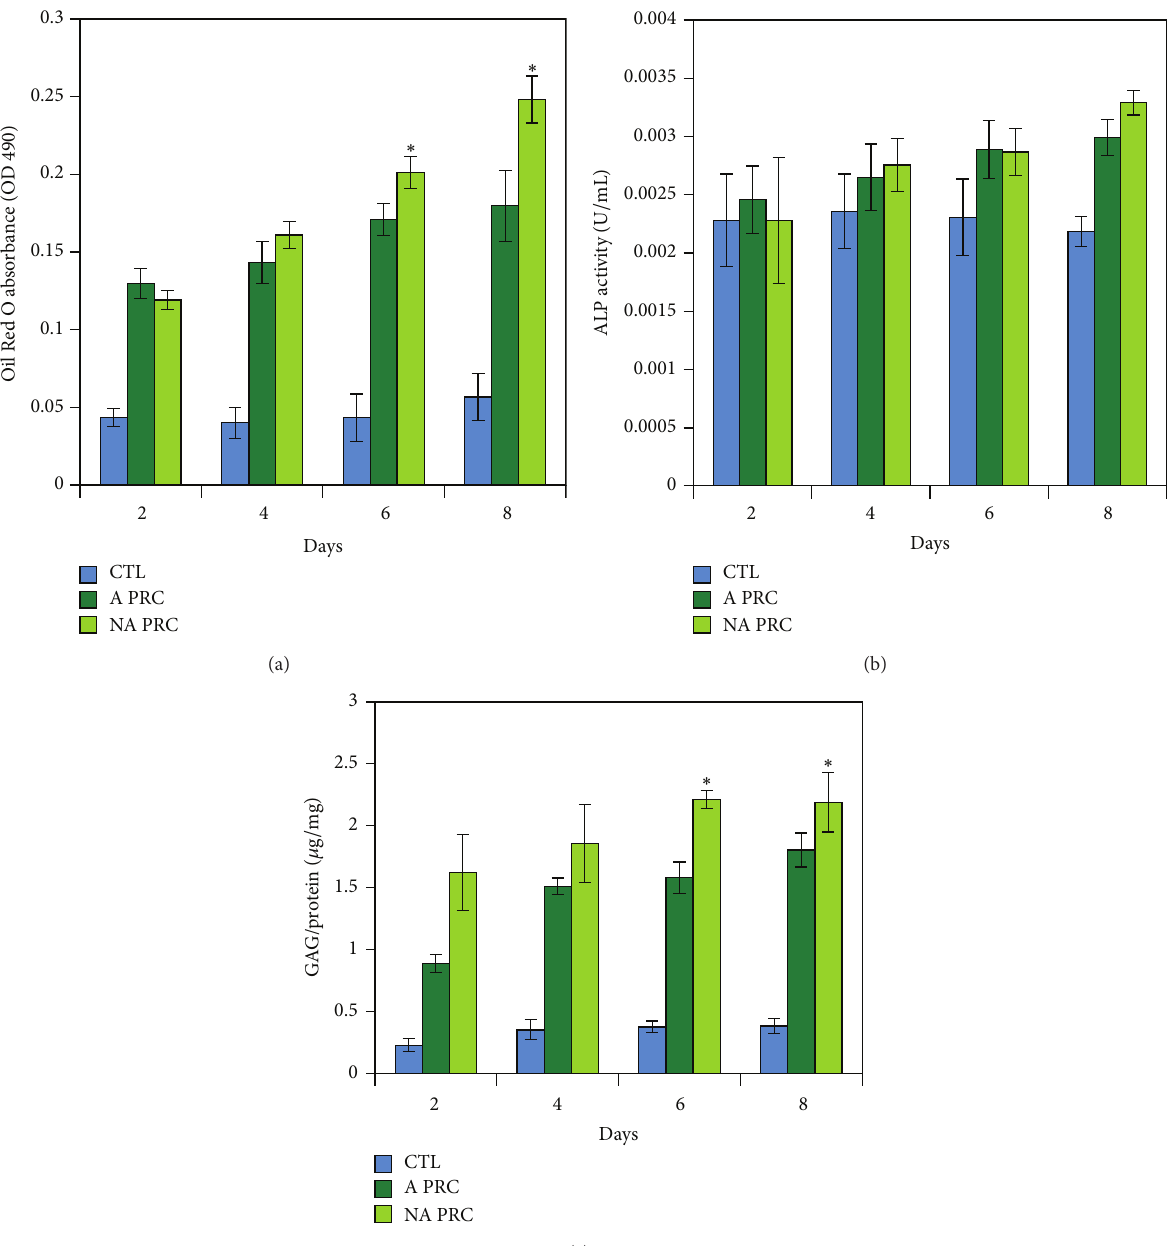
Figure 6: Differentiation assays. Adipogenesis assay shows significant increase in the nonactivated compared to activated PRC treated groups at days 6 and 8 (a). ALP activity showed no significant difference between activated and nonactivated groups (b). GAG was significantly higher in the nonactivated PRC treated groups than the activated PRC treated groups at days 6 and 8 (c). ∗ 𝑃 ≤ 0.05 .